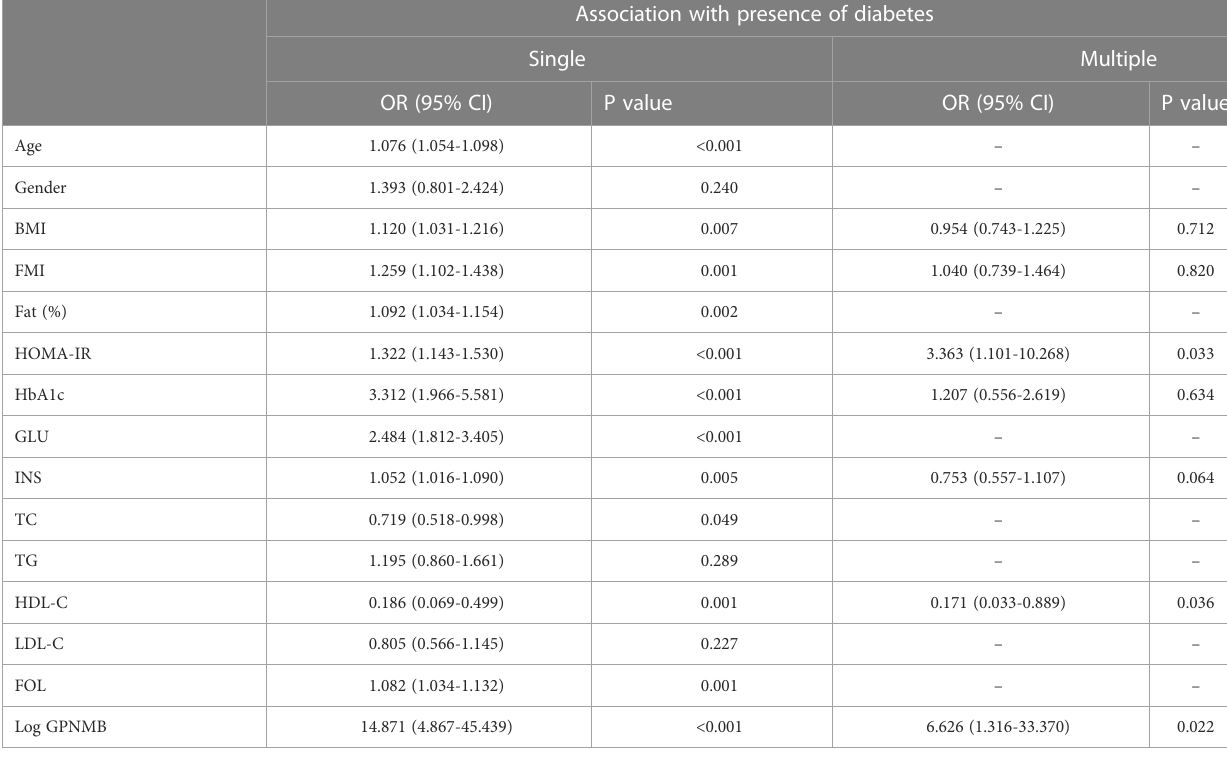
TABLE 5 Univariable and multivariable logistic regression analyses for diabetes.